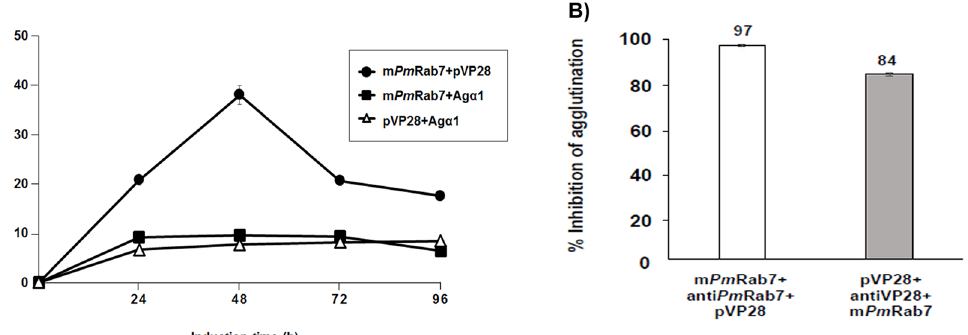
Fig 4. Yeast agglutination and agglutination inhibition assays. (A) OD 600 of His + Mut S yeast cells induced by methanol for 24 – 96 h, mixed at initial OD 600 = 0.7 and measured after 1 h. Percent agglutination was calculated from OD 600 at time zero and after 1 h. (B) Percent inhibition of agglutination by treatment of yeast cells with Pm Rab7 and VP28 antibodies for 1 h prior to agglutination assay. Percent inhibition was calculated as percent of agglutination with and without specific antibody treatment. The values were obtained from three independent experiments. Bar = means ± SD (Some of the SD bars are so small that they cannot be seen in the